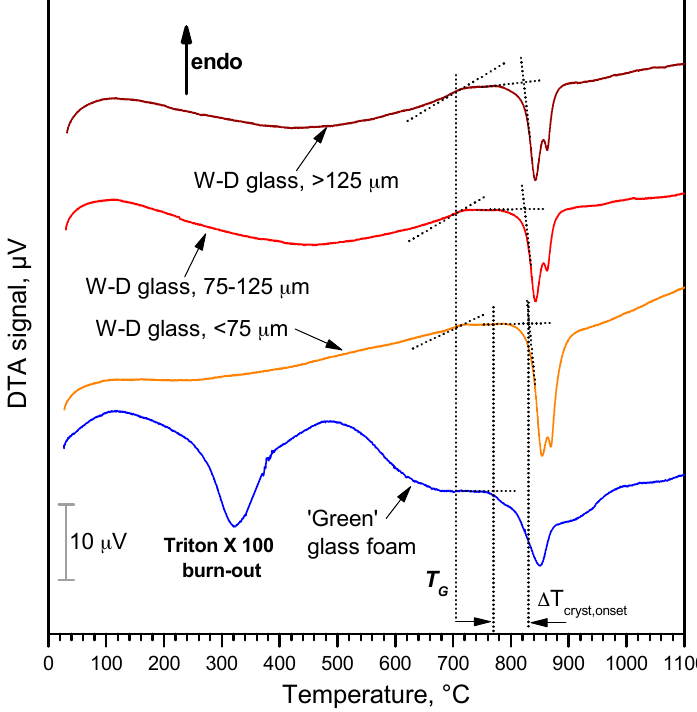
Figure 5. Differential thermal analysis of W-D glass (different particle sizes) and ‘green’ glass foam from alkali activation and direct foaming.